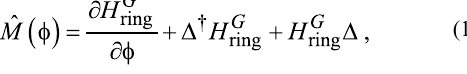
the spin–orbit interaction in the ring. This behavior is analyti- cally described in [12] and is found to be robust with respect to temperature and small deviations from half